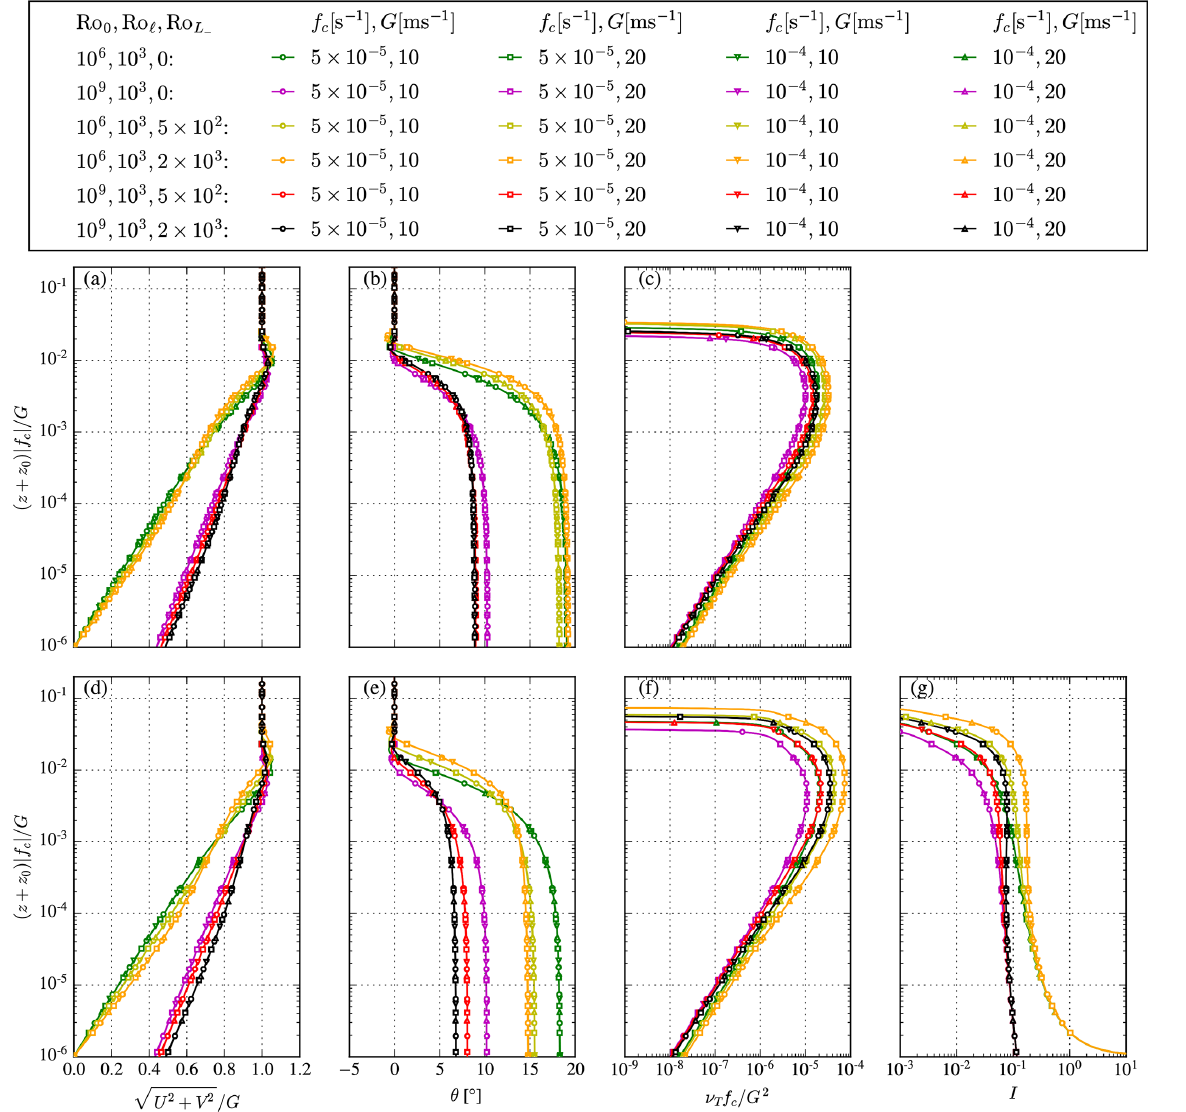
Figure 4. Rossby number similarity of the turbulence closures extended to unstable surface layer conditions. (a–c) Limited mixing-length model. (d–g) Limited-length-scale k – ε